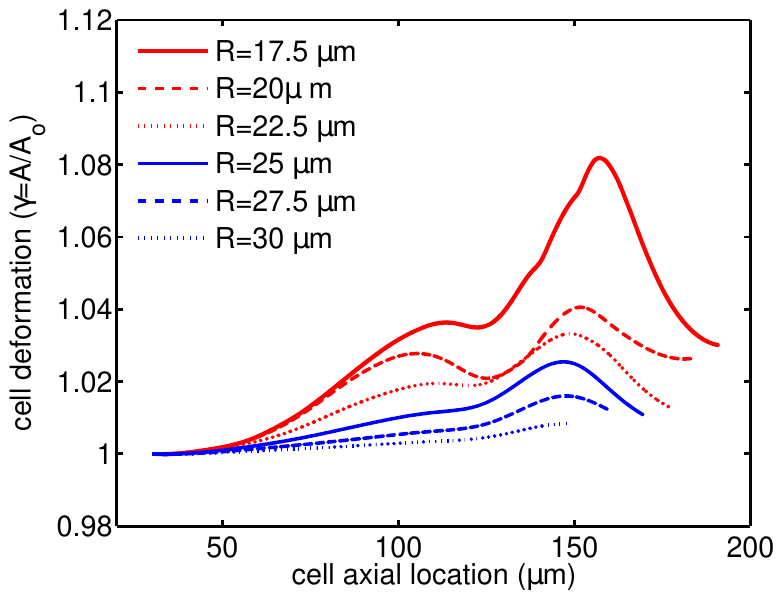
Figure 8. Deformation of an HL60 cell passing through microchannels with different constriction narrowness at λ = 0.1 s, β = 0.5, Ca = 0.00076 and Re =